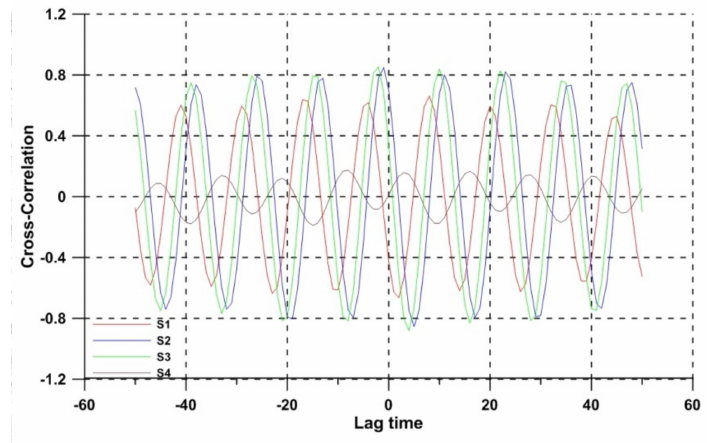
Figure 8. Cross-correlation of EC and ocean tide at S1, S2, S3, and S4 depths in well